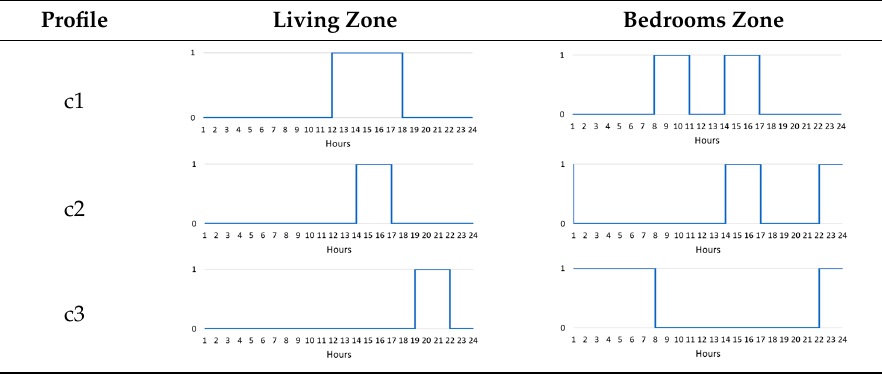
Table 4. Daily Natural ventilation schedules (Open = 1, Close = 0).